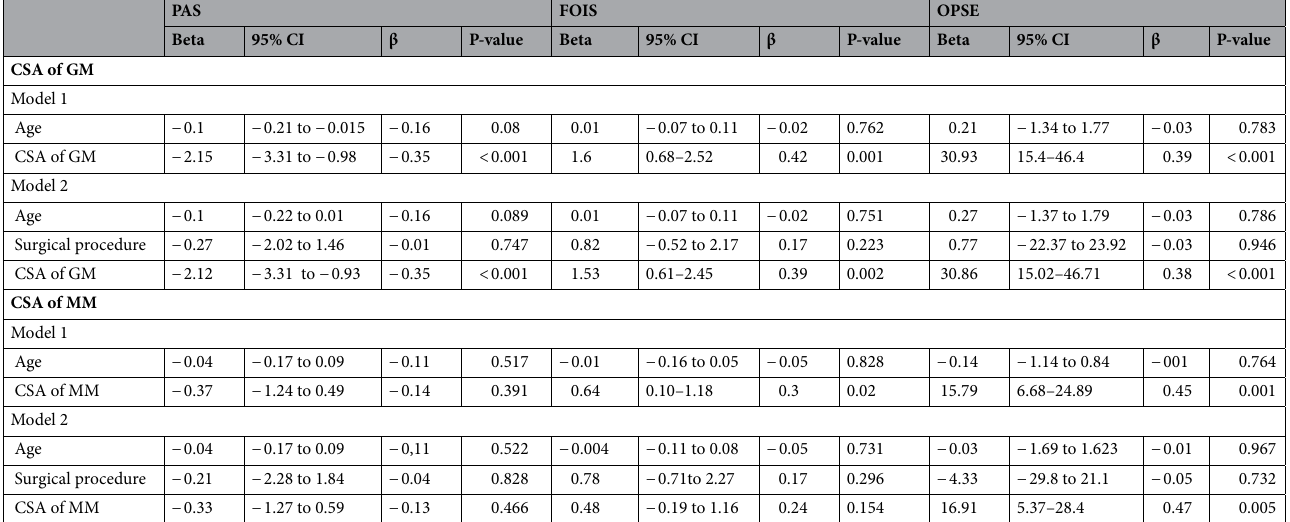
Table 4. Multivariate analysis for the Penetration Aspiration Scale score, FOIS score, and oropharyngeal swallow efficiency score after surgery. Model 1: Age-adjusted. Model 2: Age-, and surgical lesion and procedure-adjusted. PAS penetration aspiration scale, FOIS Functional Oral Intake Scale, OPSE oropharyngeal swallow efficiency, CSA cross-sectional area, GM geniohyoid muscle, MM masseter muscle, CI confidence